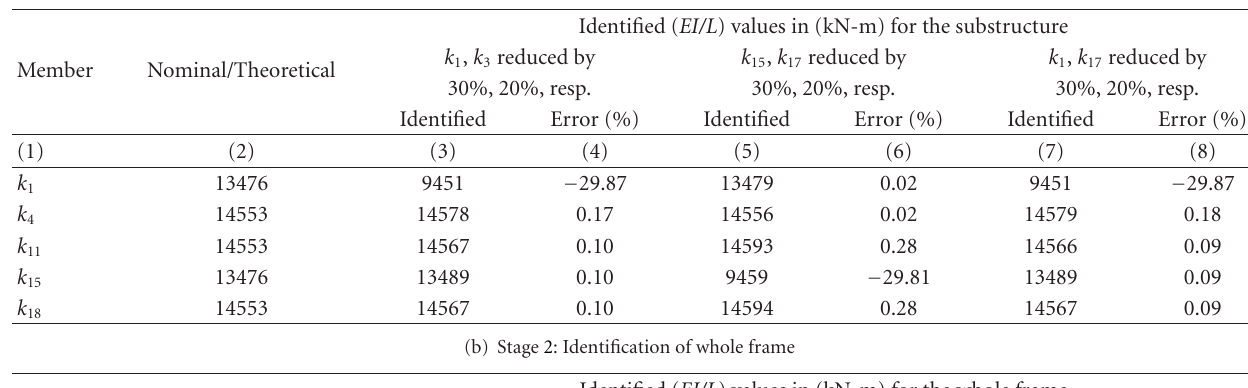
Table 3: Sti ff ness parameter ( EI/L ) identification for defect 2 using GILS-EKF-UI.